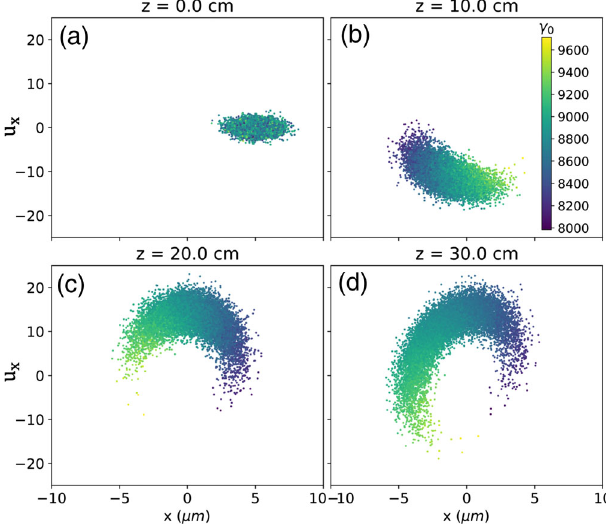
FIG. 3. Phase diagram x − u x at different z along propagation. Simulation conditions are given in Table I. The laser pulse propagated on axis, and the electron beam started with an initial 5 μ m transverse offset. Colors represent the electron initial Lorentz factor.